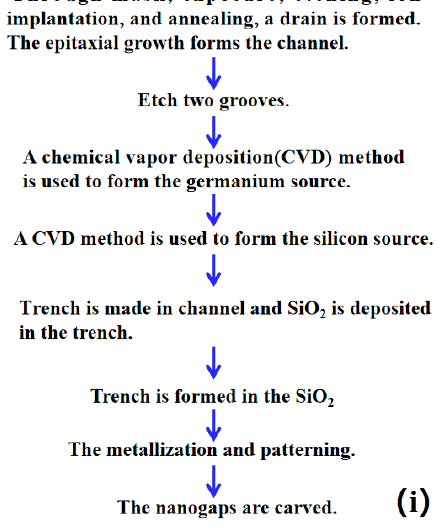
Figure 3. (a) – (i) Tentative fabrication flow for a DM-SSTGTFET biosensor. Figure 3. ( a – i ) Tentative fabrication flow for a DM-SSTGTFET